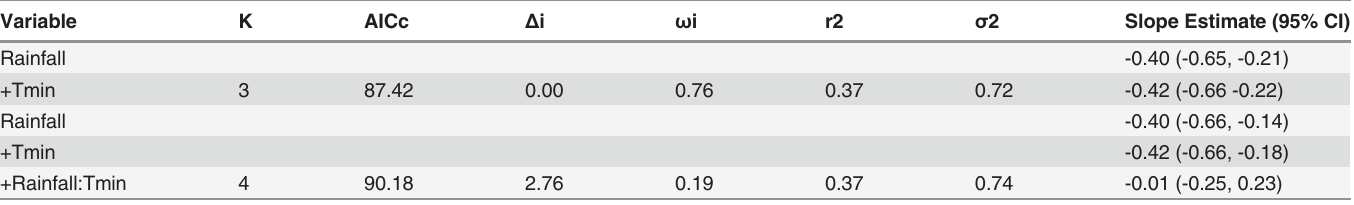
ω 2 = regression i ) = AIC weight, r